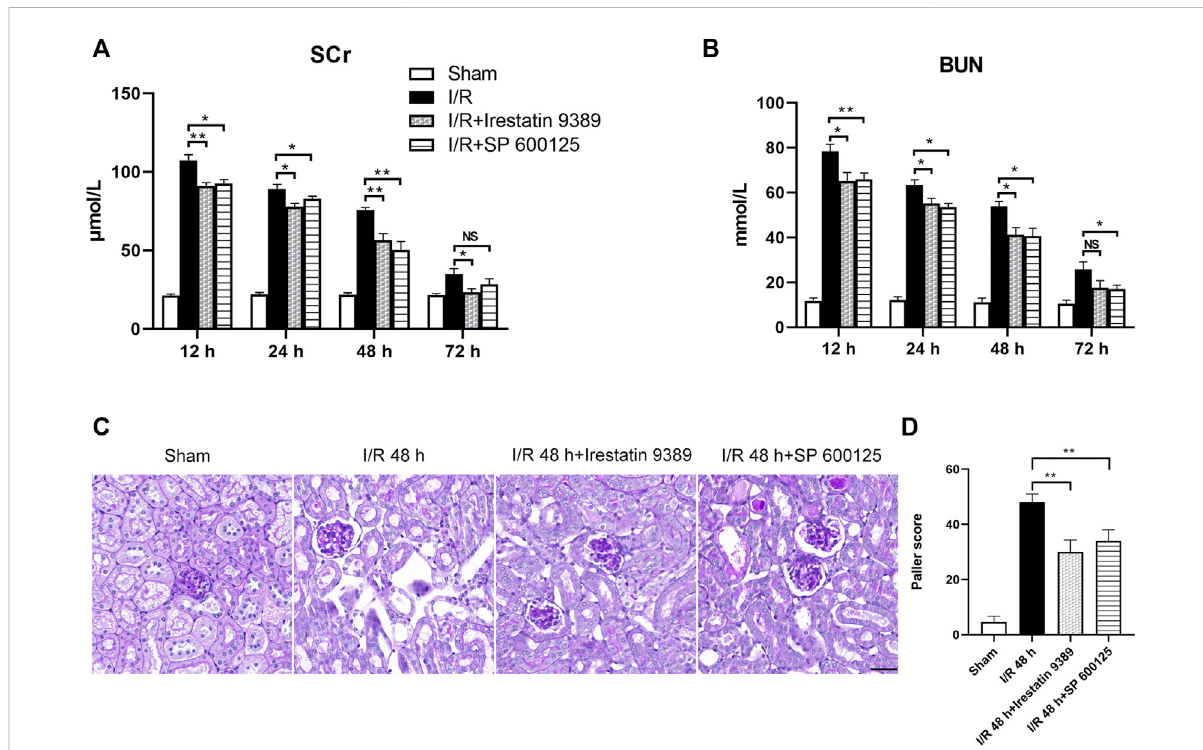
FIGURE 5 Comparison of renal injury among the sham, I/R, I/R + Irestatin 9389, and I/R + SP 600125 groups. The levels of Scr (A) and BUN (B) in all four groupsat12,24,48and72 hafterI/Rorshamcondition (C) PASstainingshowedthepresenceofrenaltubularlesionsinallfourgroupsat48 hafterI/ R. Scale bar = 50 μ m (D) The Paller scores of each group in PAS staining. Results were presented as mean ± SD. Due to the death of mice, N = 5 for each group. Statistical signi fi cance is denoted as *: p < 0.05, **: p < 0.01, NS: p > 0.05 in two